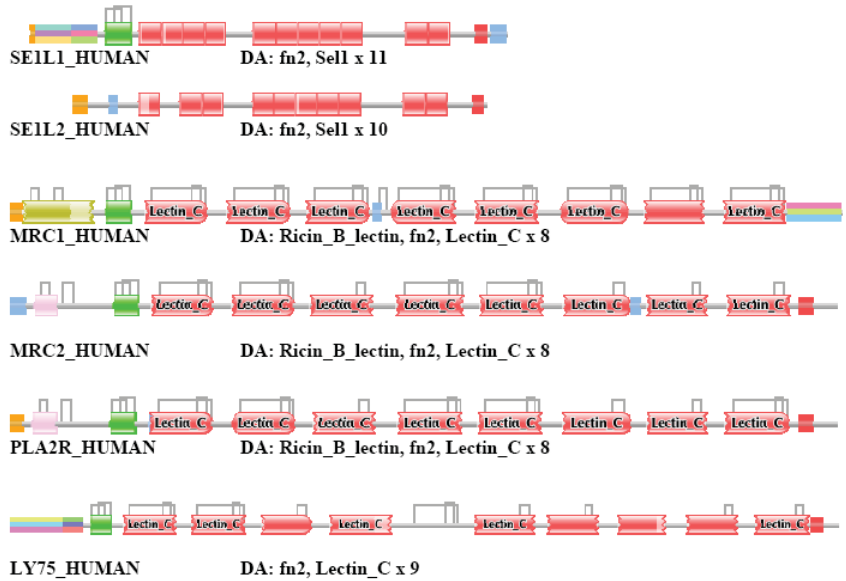
Figure S7. Comparison of the domain architecture of SE1L1_HUMAN with those of its closest paralogs and some epaktologs.